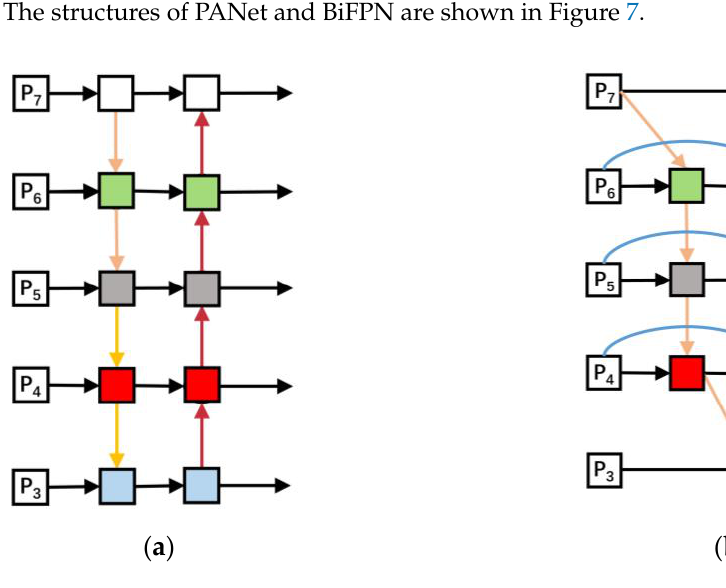
Figure 7. Structural diagram of ( a ) PANet and ( b ) BiFPN.